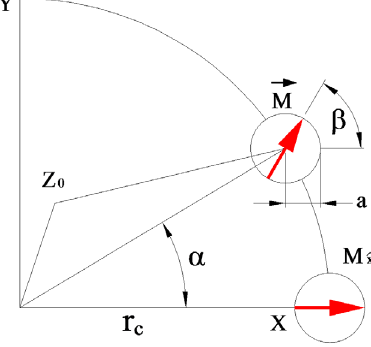
FIG. 1. Position of the reference magnet at ð r magnetization along the X axis and another magnet placed at ; α Þ whose magnetization makes an angle an arbitrary angle at ð r c β with the X